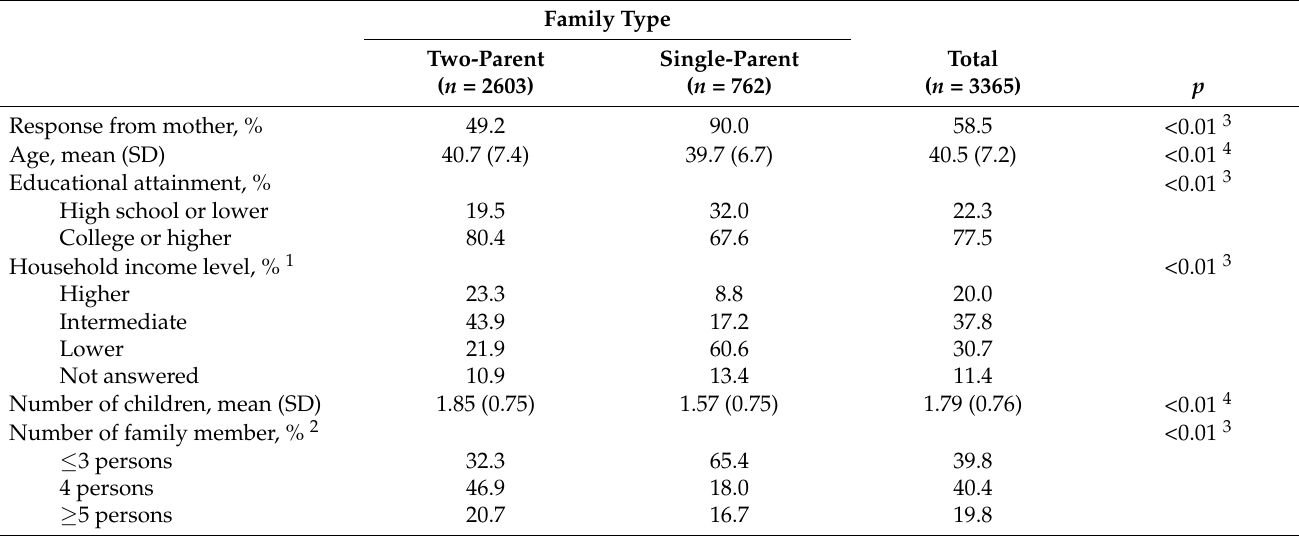
Table 1. Parent and child characteristics by family type ( n =